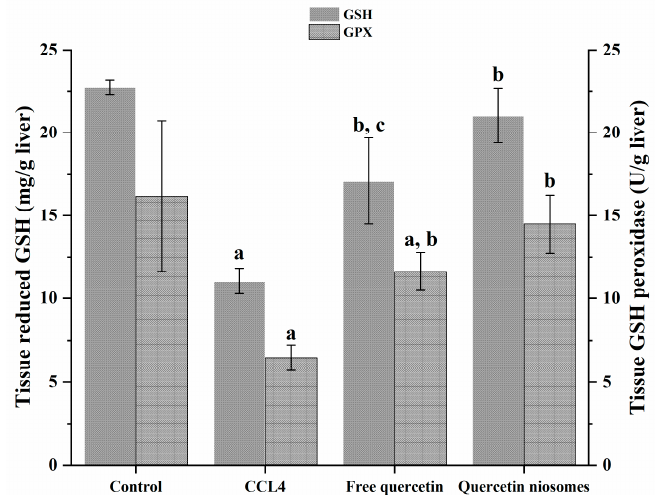
Figure 7. Effect of pretreatment with free quercetin and quercetin niosomes on GSH level and GPX activity. Notes: a = significantly different from control group; b = significantly different from CCl 4 group; c = significantly different from quercetin niosomes.